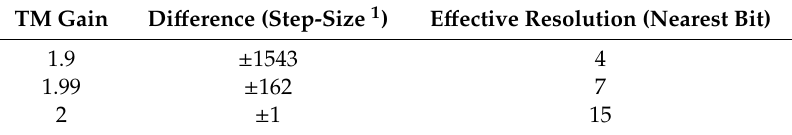
Figure 2. Graphs showing the effects non-ideal TM gain has on the accuracy of a 15 TM-stage TM-based ADC. Table 1. Reduction in the TM-based ADC accuracy due to TM gain.